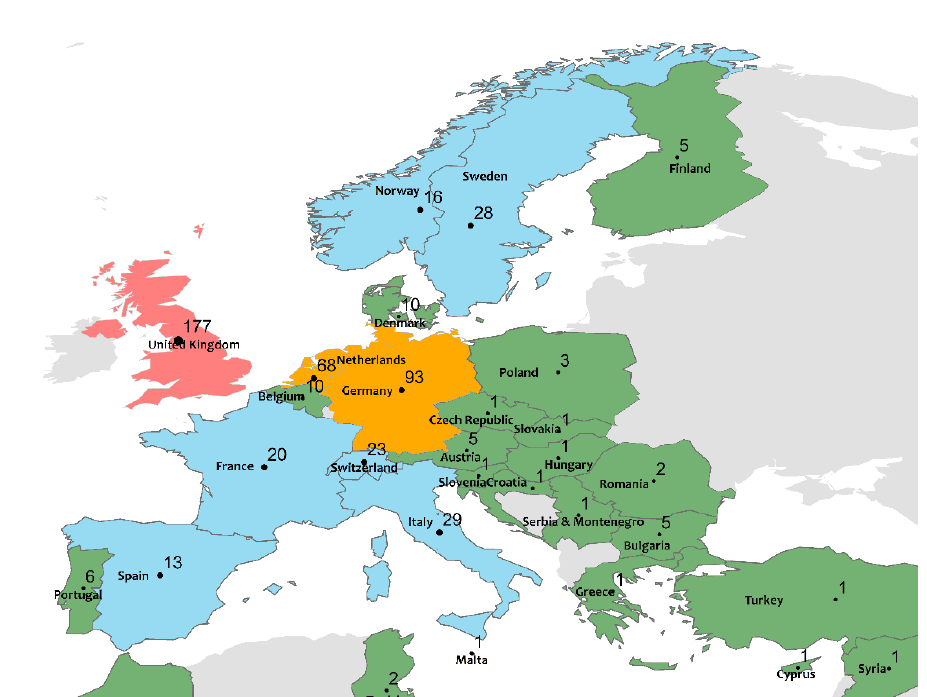
Figure 2. Geographical distribution of global risk communication research.